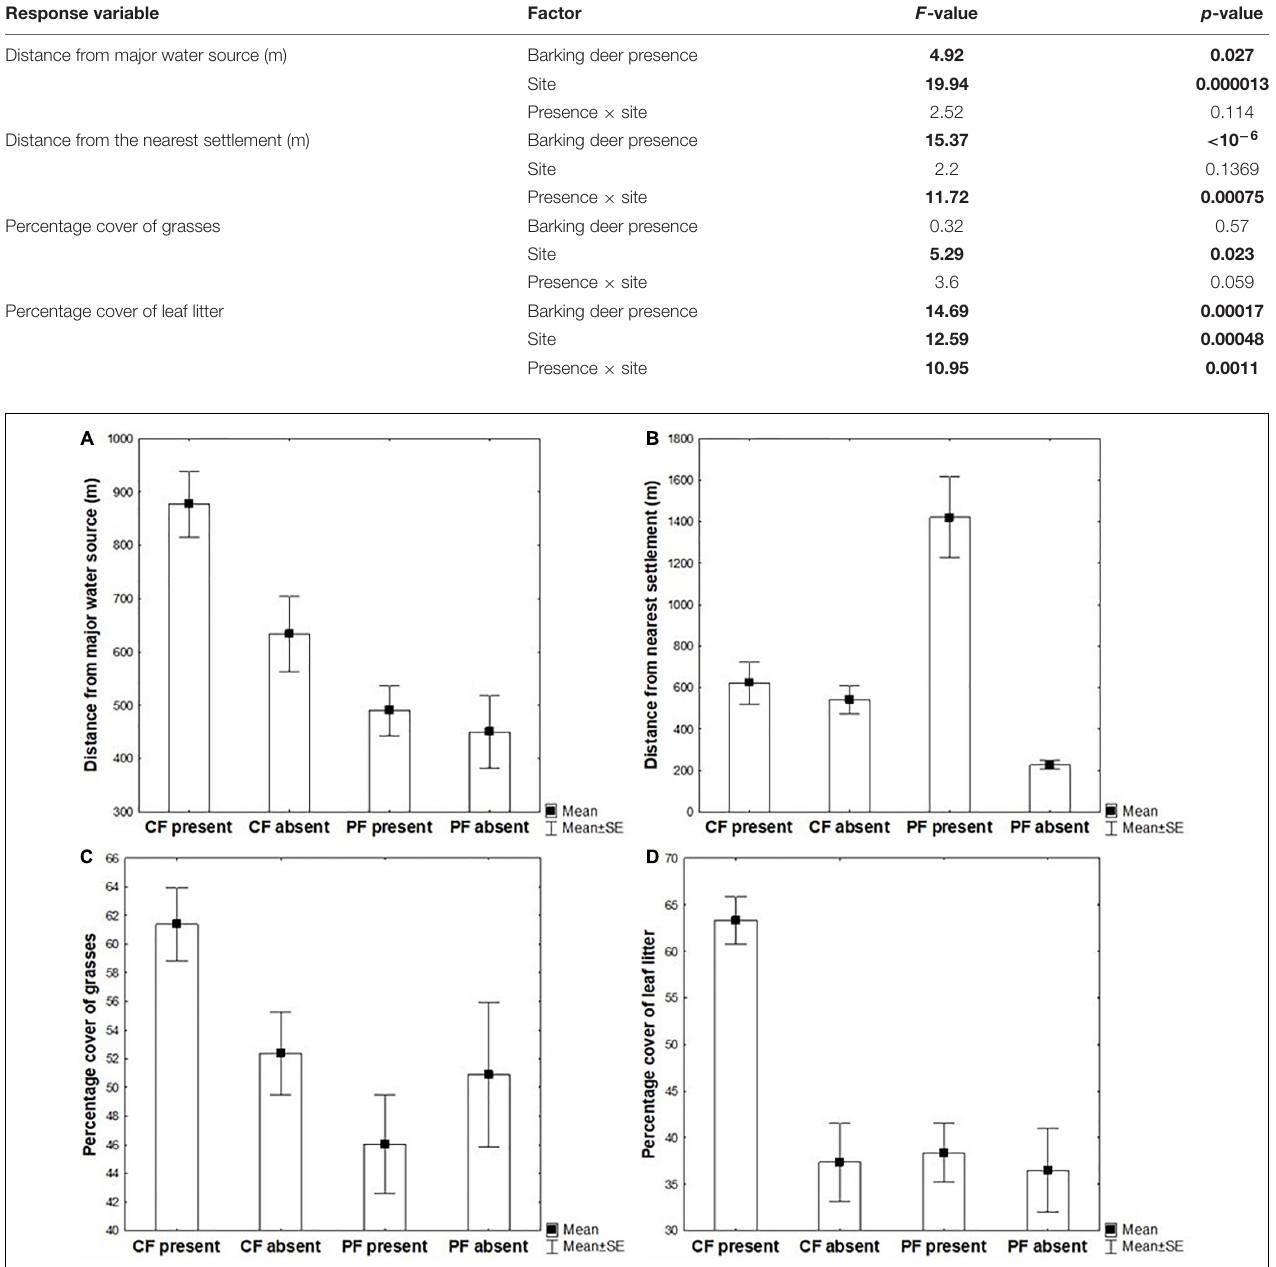
FIGURE 3 | The means and standard errors for each combination of the response variables “distance from major water source” (A) , “distance from the nearest settlement” (B) , “percentage cover of grasse,” (C) and “percentage cover of leaf litter” (D) and each of the factors “barking deer presence” (present – “used plot,” absent – “habitat availability plot”) and “site” (Community Forest – CF, Protected Forest –